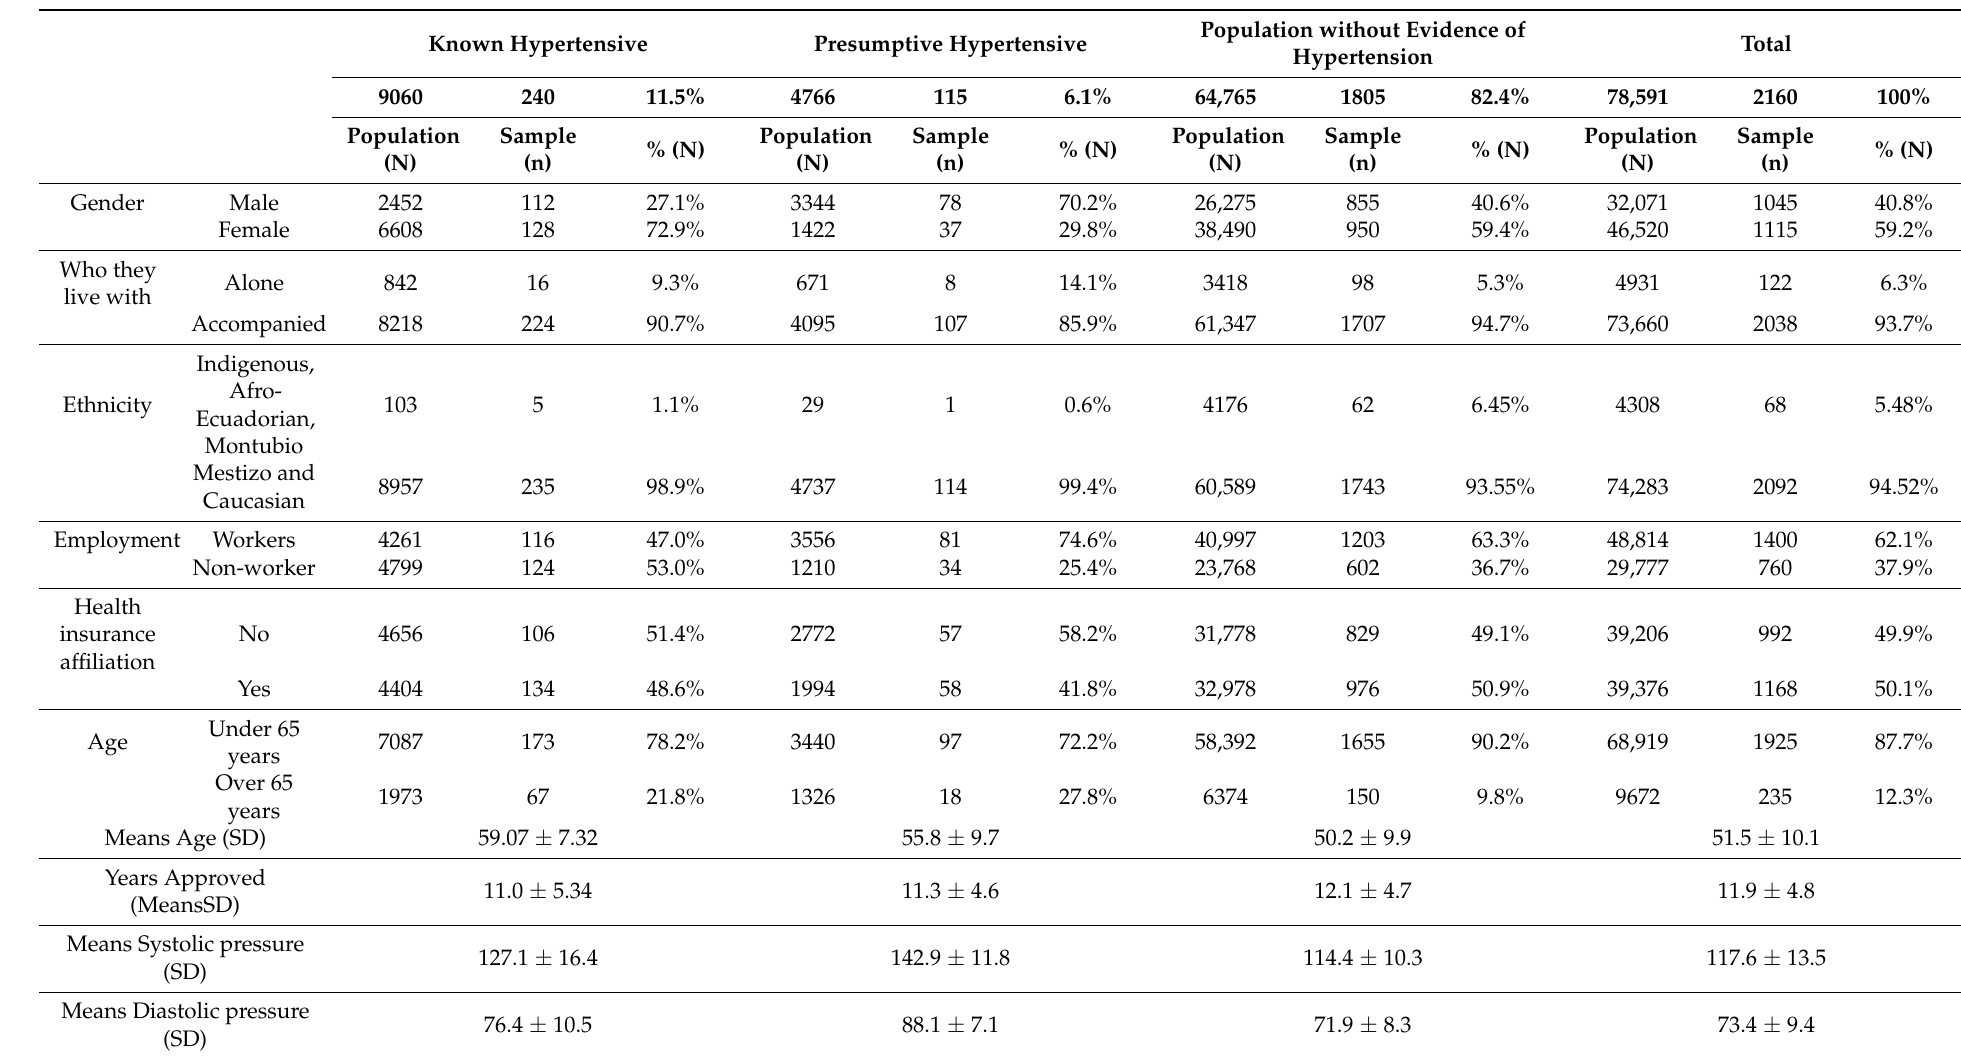
Table 1. Sociodemographic characteristics of the urban population of the community of Conocoto.